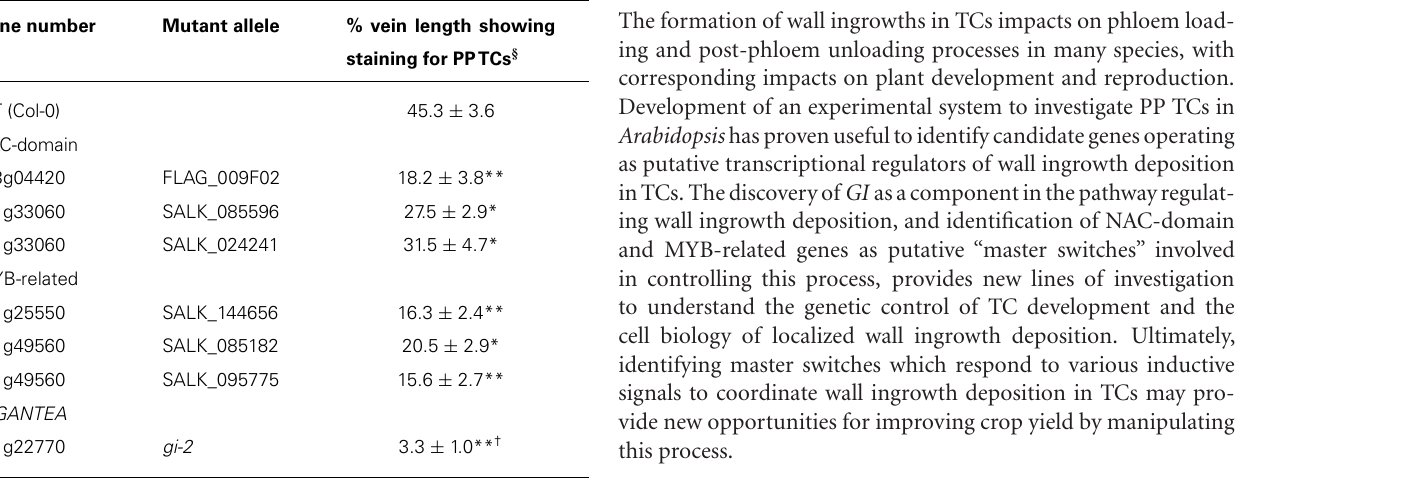
Table 1 | Phenotypic analysis showing reduced abundance of PPTC staining for two NAC-domain and two MYB-related genes identified by bioinformatics as candidate transcriptional regulators of wall ingrowth deposition in PPTCs of Arabidopsis leaf